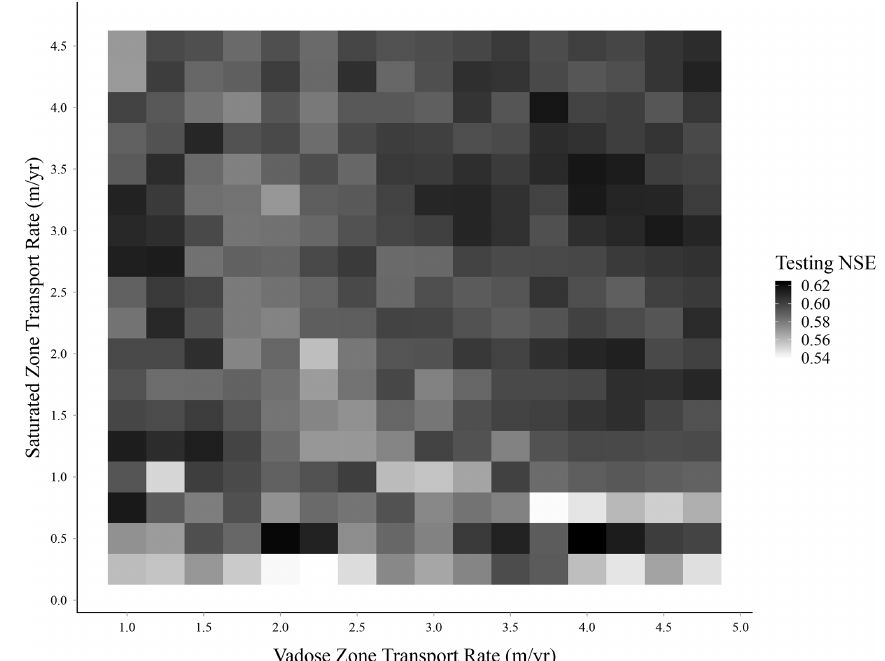
Figure 4. Heat map of testing NSE results from 288 vadose and saturated zone transport rate combinations. Testing NSE in this figure is the median of all 25 model outputs from each of the 288 transport rate combinations. No clear pattern of optimal vadose and saturated zone transport rate combinations was observed.